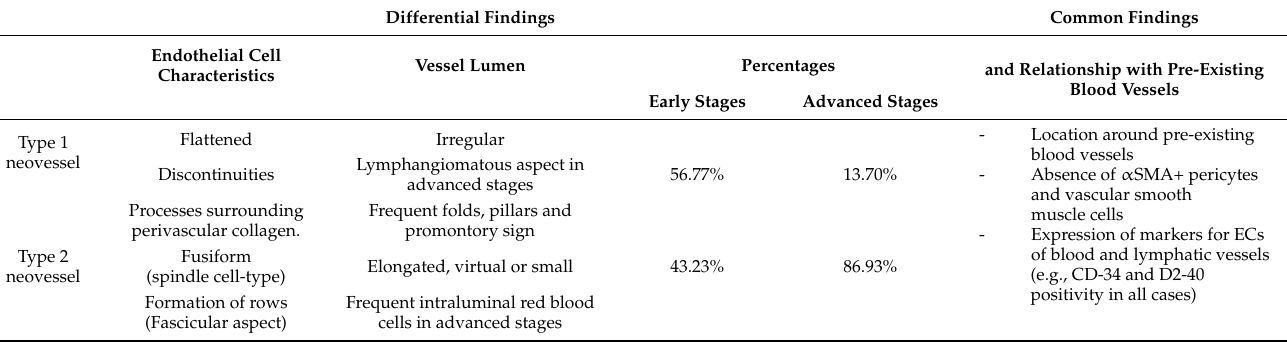
Table 1. Data refer to the cases in which immunochemistry was performed ( n : 30). Standard deviation in percentages of the groups of early and advanced stages were 12.22 and 8.02, respectively. Early stages vs. advanced stages: significant. p < 0.05. Differential Findings Common